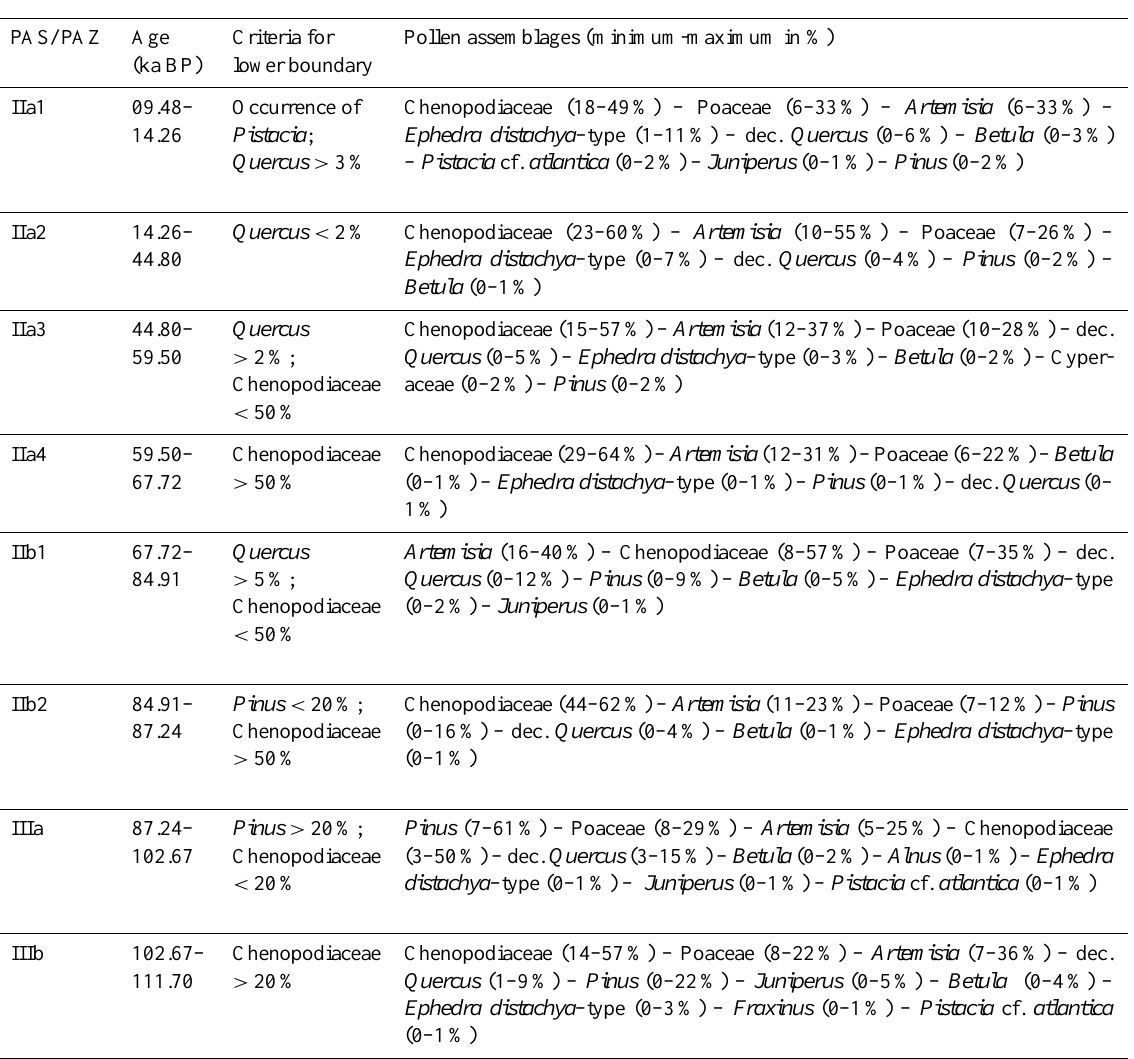
Table 1. Simplified synoptic description of pollen assemblage superzones (PAS) and zones (PAZ). PAS/